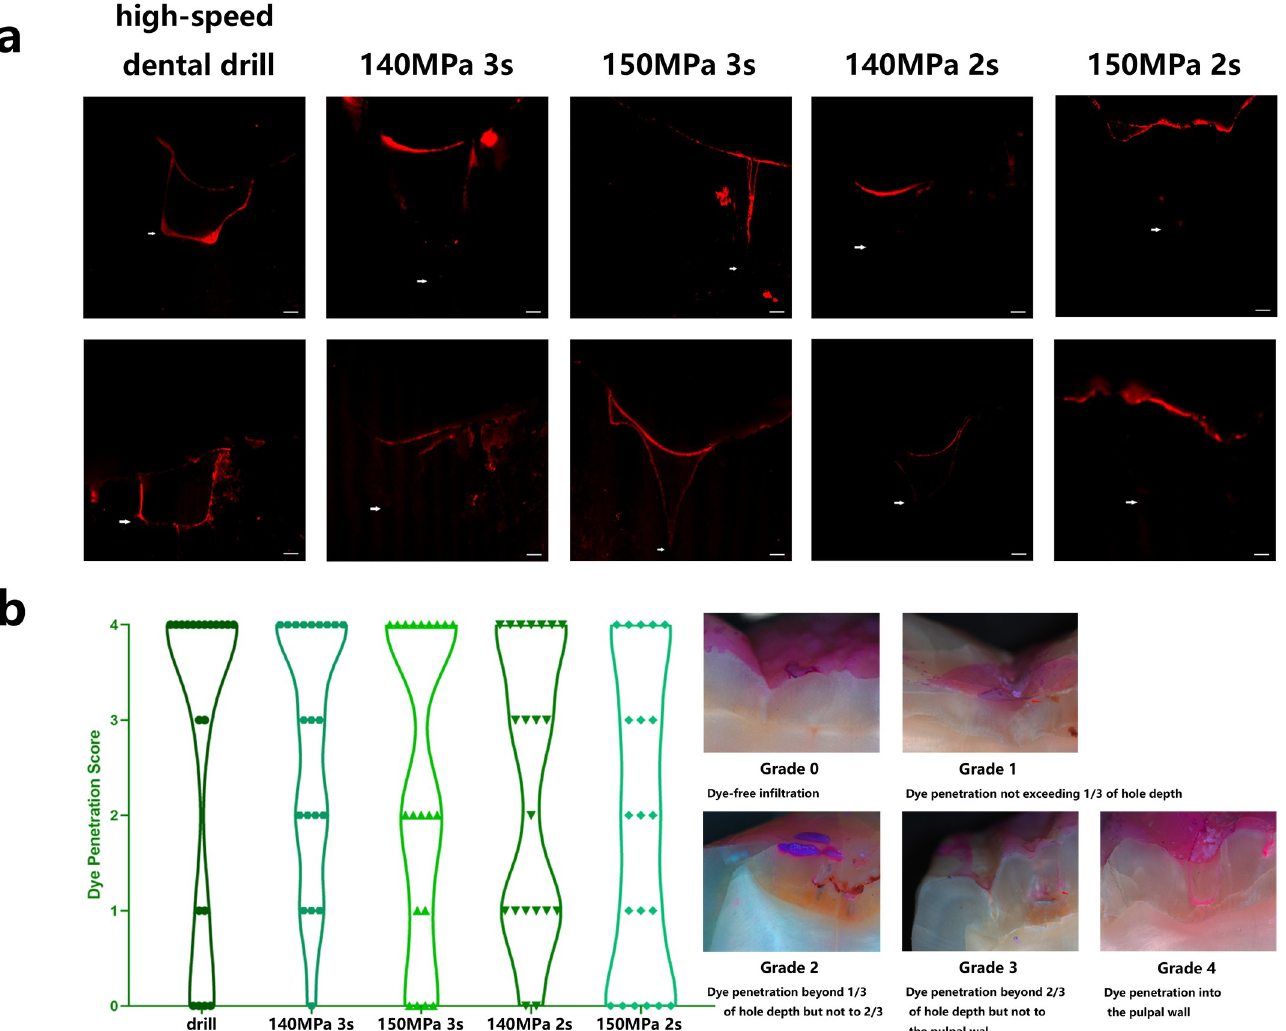
Fig 6. Observation of microleakage. a, CLSM images of microleakage of well-filled cavities prepared with a water jet or a high-speed dental drill (arrows show the bottom of the resin, scale bar = 200 μ m). b, The dye penetration score under stereomicroscope observation of well-filled cavities prepared with a water jet or a high-speed dental drill in a violin plot (n = 20). The dye penetration score was used for the evaluation of example images (arrows show the bottom of dye penetration).